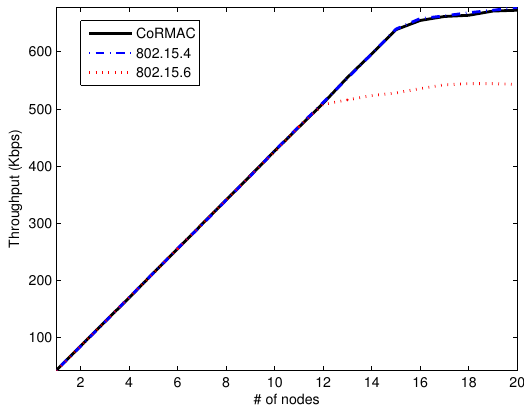
Figure 9. The average throughput of data vs. the number of